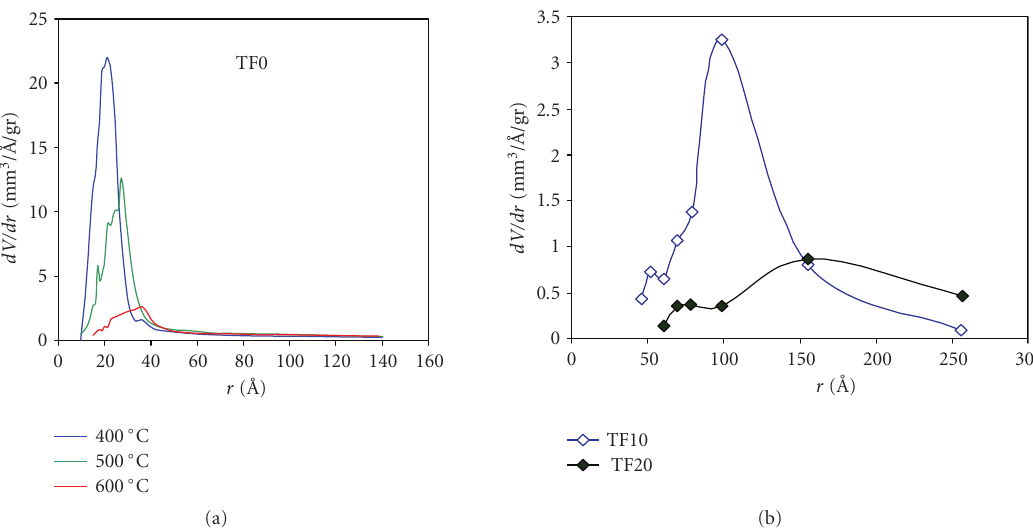
Figure 4: Pore size distribution in the undoped TiO 2 calcinated at di ff erent temperatures (a) and in the TF10 and TF20 powders calcinated at 400 ◦ C (b).